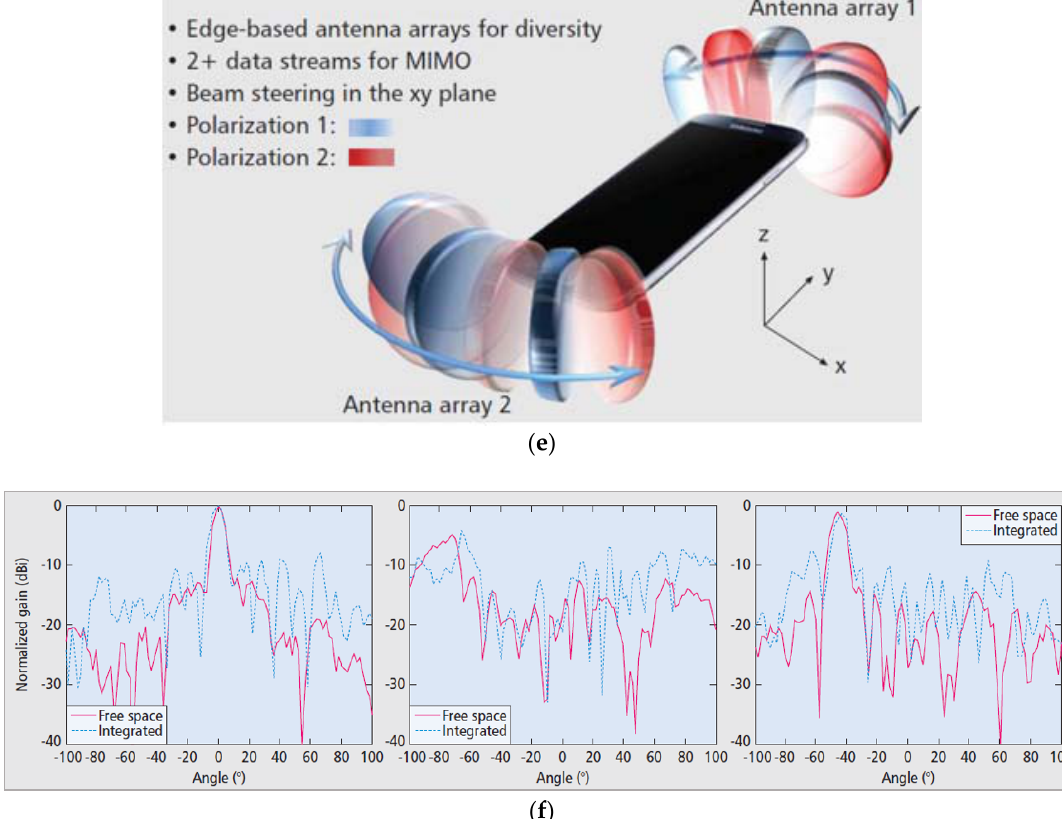
Figure 5. ( a ) Comparative illustration of the standard cellular antenna and mm ‐ wave 5G antenna. ( b ) Proposed antenna. ( c ) Prototype photograph of the standalone mm ‐ wave antenna array with coaxial connectors. ( d ) Photograph of mm ‐ wave 5G cellular antenna array integrated inside a Samsung handset and zoomed ‐ in views of 5G mm ‐ wave antenna array. ( e ) mm ‐ wave antenna array configuration for 5G cellular mobile terminals. ( f ) Measured and normalized radiation patterns for different beam directions (Figure 5f redrawn from [10]).